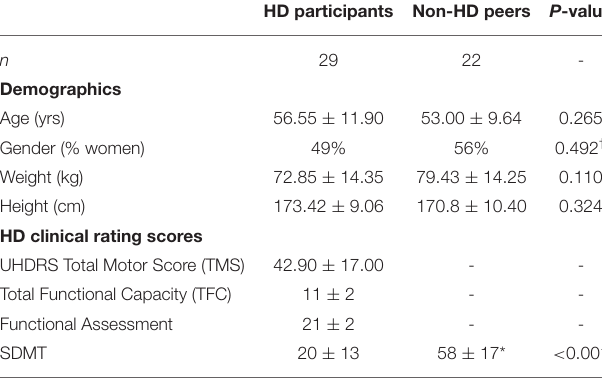
TABLE 1 | Participant